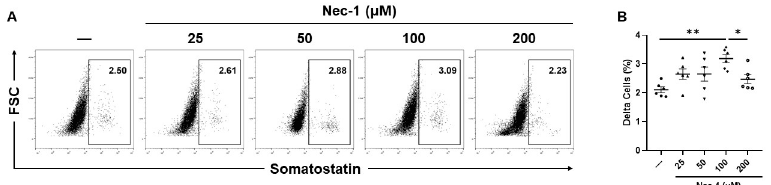
Fig 6. Delta-cell composition of islets after 7 days of tissue culture in control media (—) or media supplemented with 4 different doses of necrostatin-1 (25, 50, 100, or 200 μ M of Nec-1) on day 3. 3000 islet equivalents were dissociated into single cells using Accutase, stained with 7-amino-actinomycin D (7-AAD) viability dye and fluorescein-isothiocyanate-conjugated anti-somatostatin antibody, and analyzed by flow cytometry to quantify the proportion of delta cells in islets. Somatostatin-positive delta cells were gated on 7-AAD-negative live cells. A) Representative flow cytometry plots of somatostatin staining. B) Percentage of somatostatin-positive delta cells. n = 6 for each group. � p < .05. �� p < .01. Data are expressed as mean ±